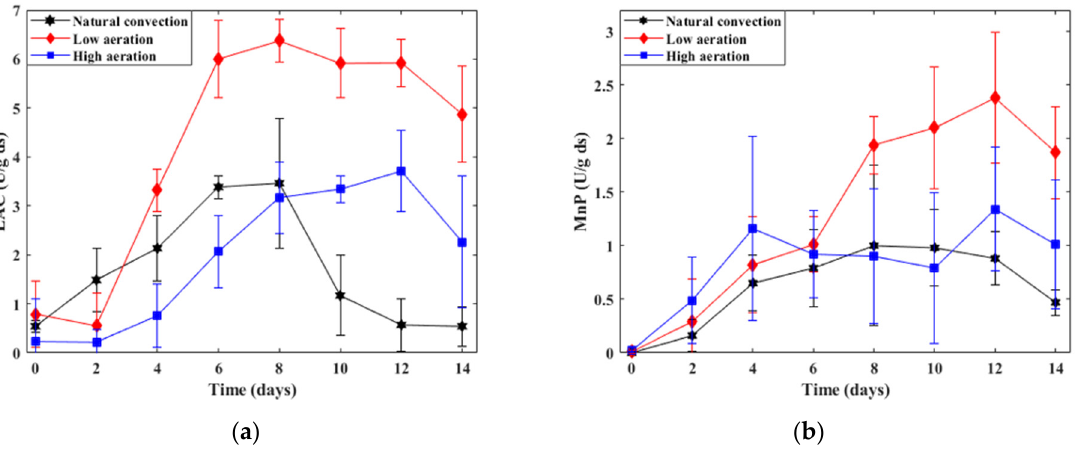
Figure 4. Time profile of laccase ( a ) and manganese peroxidase ( b ) activities of T. versicolor cultivated in a fixed-bed pilot-scale bioreactor for 14 days of solid-state fermentation; ds: dry solid; LAC: laccase; MnP: manganese peroxidase.